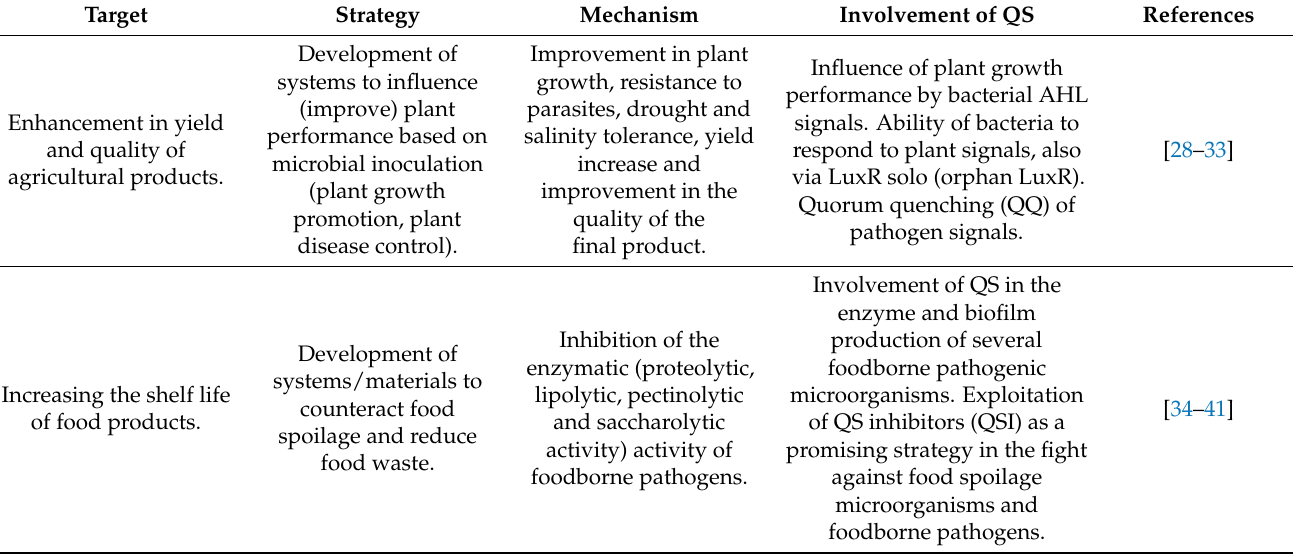
Table 1. Representative eco-friendly strategies to overcome food crisis, exploiting QS